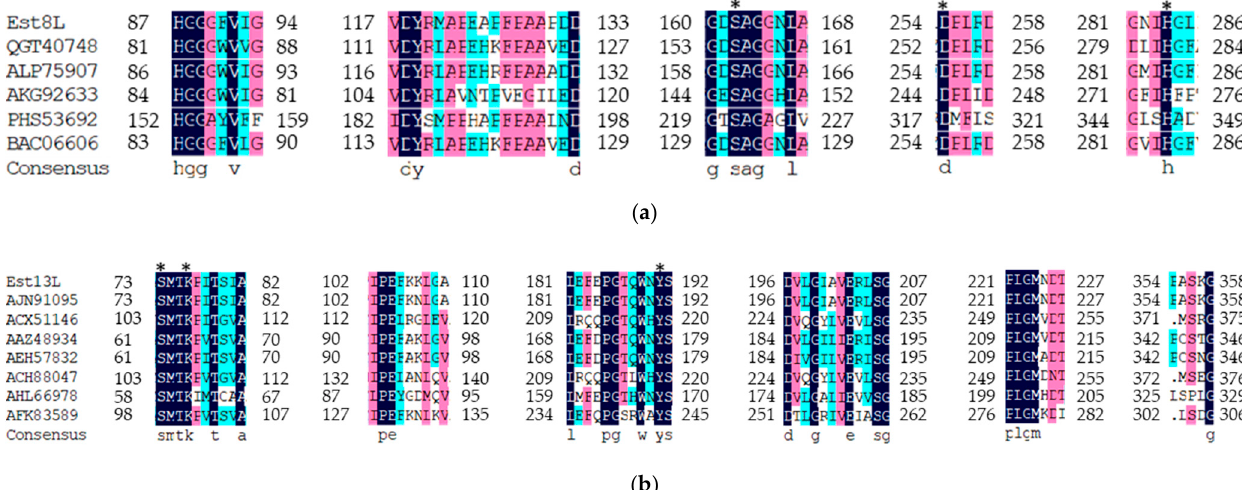
Figure 2. Multiple sequence alignments of Est8L ( a ) and Est13L ( b ) using the Clustal W method in DNA/MAN. The aster- isks represent the catalytic triads. Family IV esterases: QGT40748, carboxyl esterase E2 (expression vector